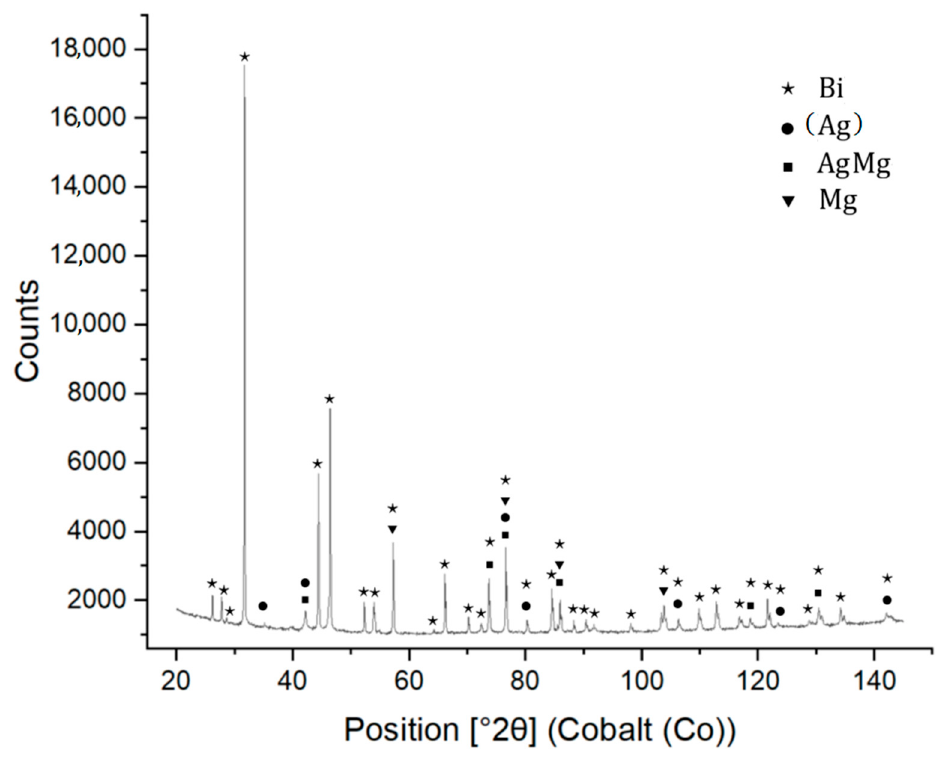
Figure 11. XRD analysis of Bi11Ag1Mg